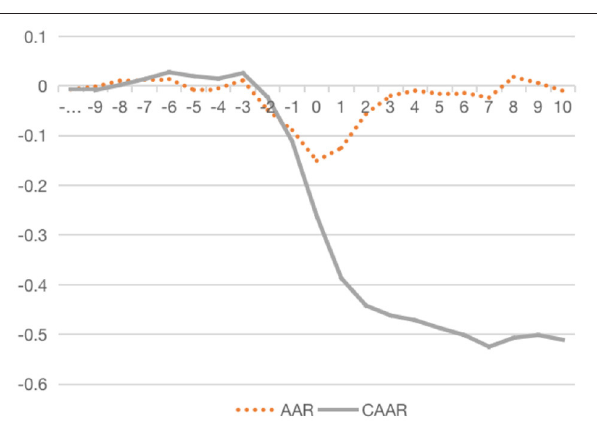
FIGURE 1 | AAR and CAAR of crisis firms during the incident